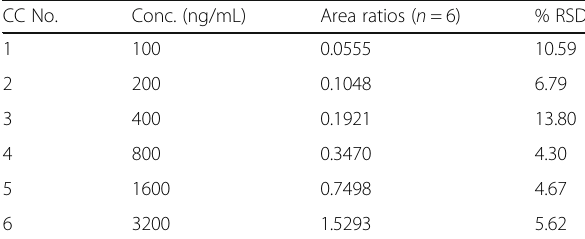
Table 2 Area ratios from calibration